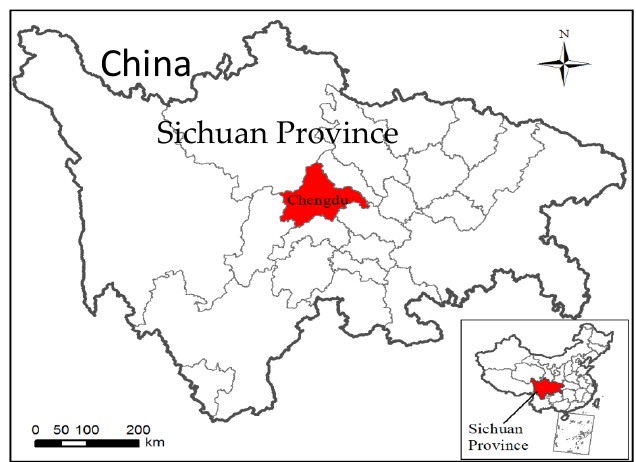
Figure 1. Location of the study area.